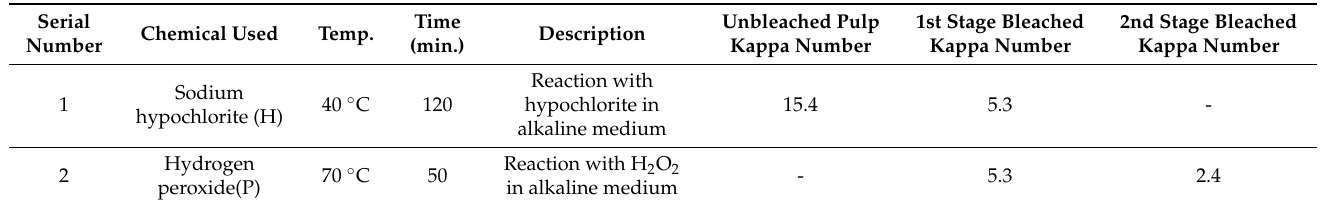
Serial Number Chemical Used Temp.